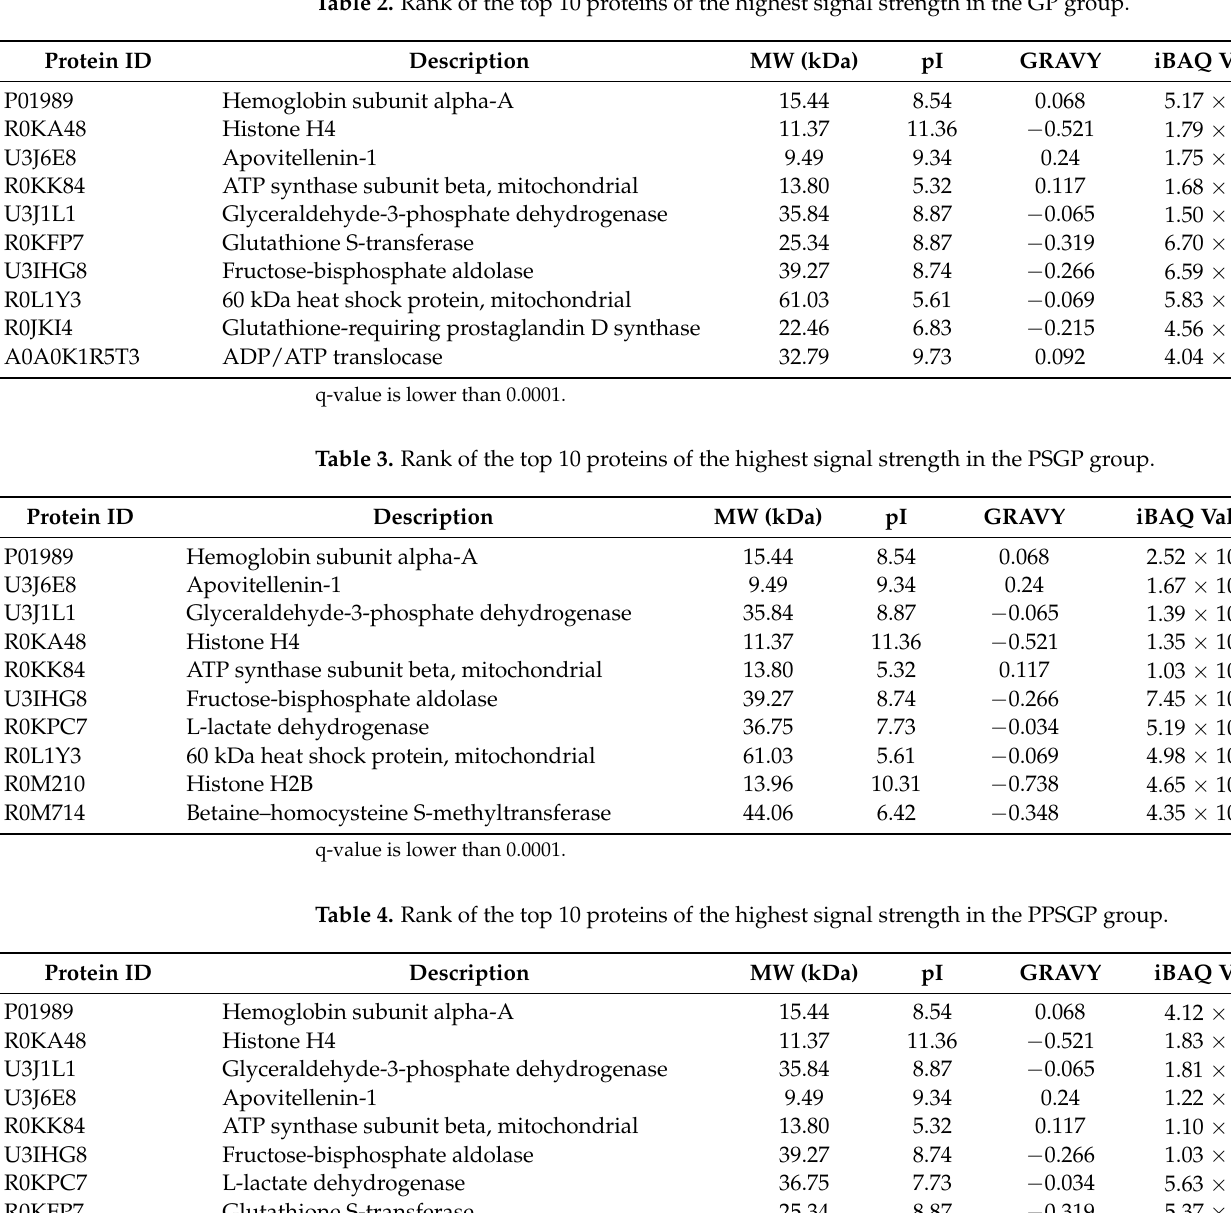
Table 2. Rank of the top 10 proteins of the highest signal strength in the GP group.